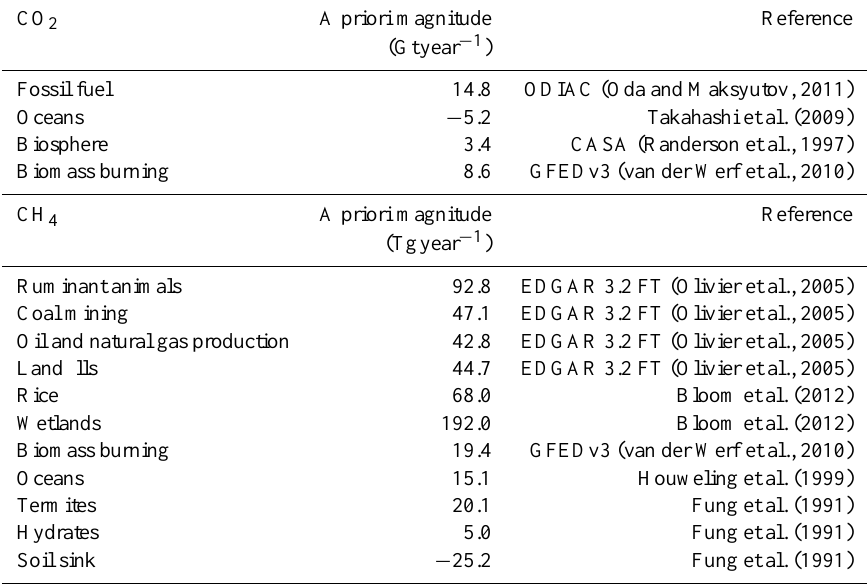
Table 1. A priori sources of carbon dioxide and methane used in the GEOS-Chem model for